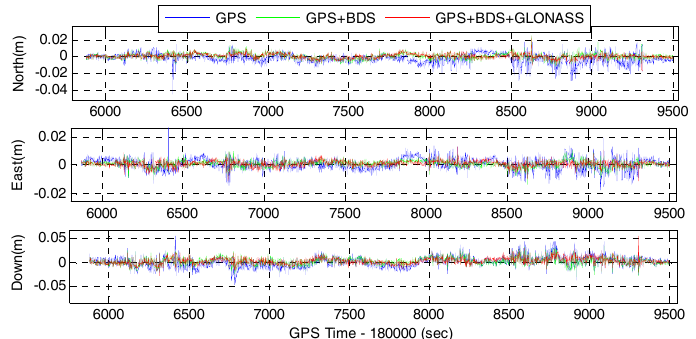
Figure 9. Position difference of RTK for GPS, GPS/BDS, GPS/BDS/GLONASS at 15° cut-off elevation angle.